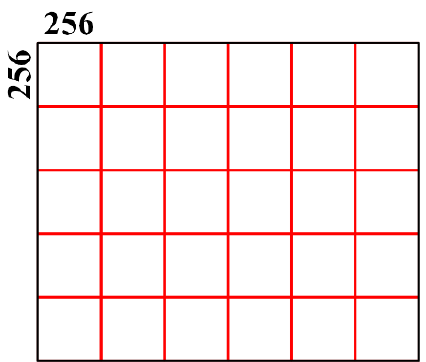
Figure 3. Image partition example for an image. The original valid image is indicated by the black box. According to the red grid, the image is partitioned into a set of small non-overlapping 256 × 256 pixel images.